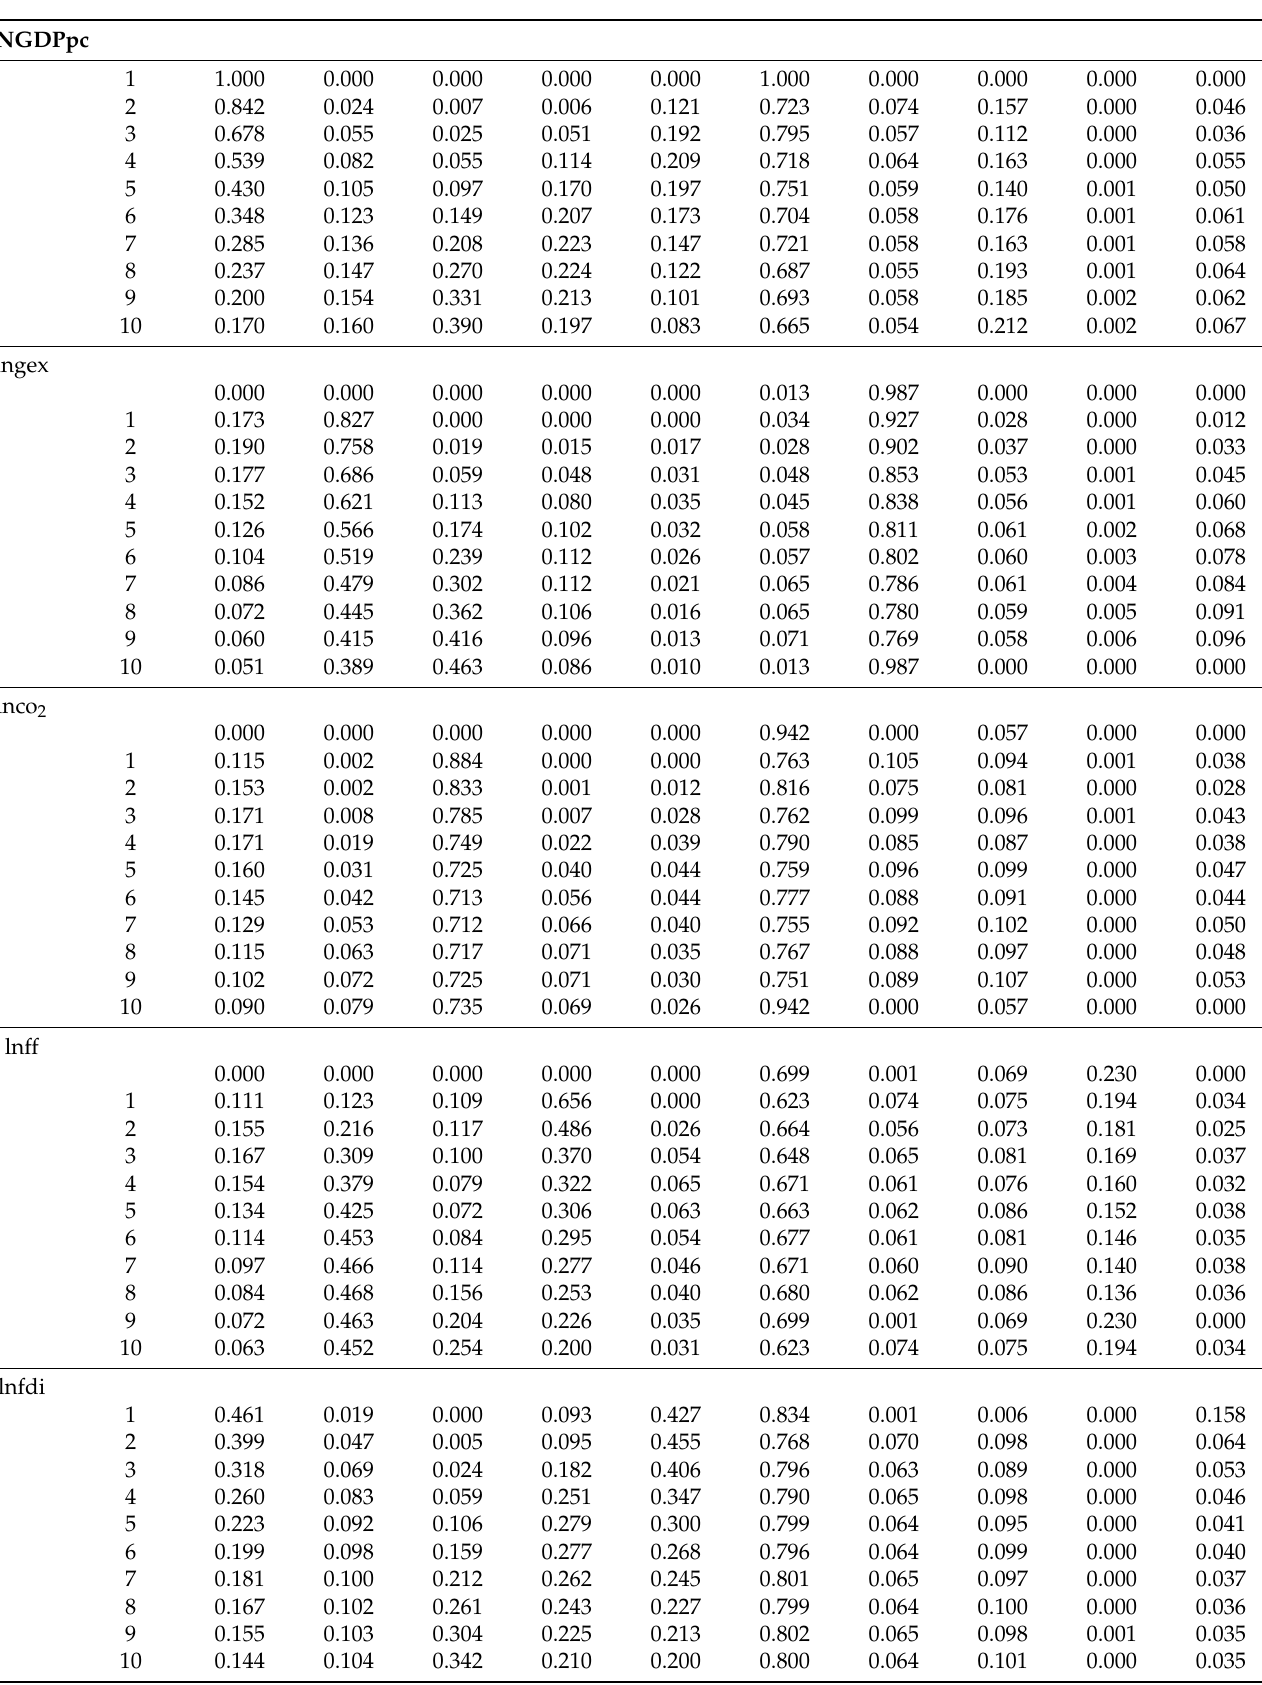
Table 7. Variance decomposition